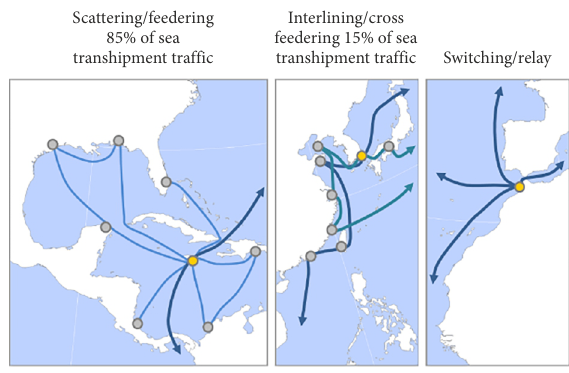
Figure 1. Transhipment functions (Rodrigue et al.